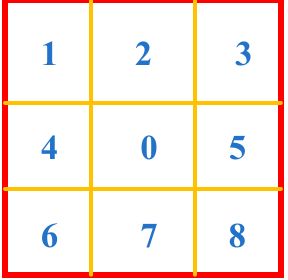
Figure 3. The central pixel and its eight adjacent pixels.